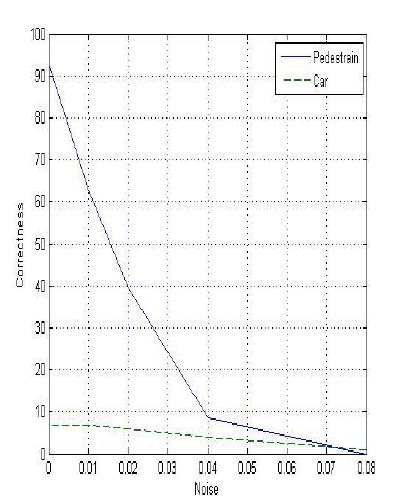
Figure 5. Comparison of various input noise with correct percentage of car and pedestrian detection